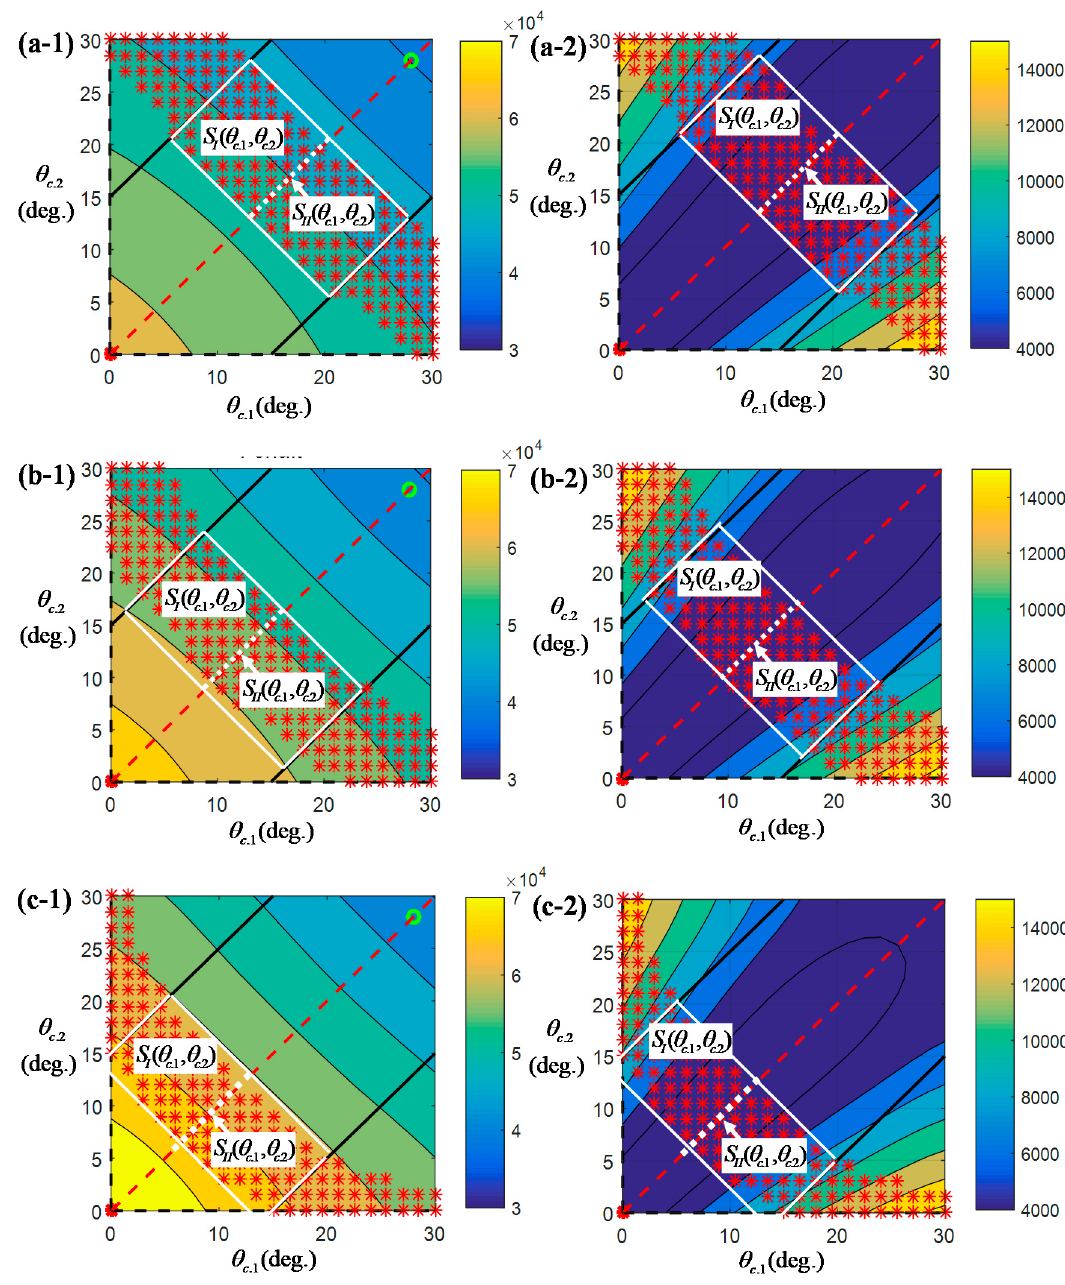
Figure 9. Average steady-state radial and axial forces, F ave . radial ( θ c .1 , θ c .2 ) and F ave . axial ( θ c .1 , θ c .2 ) , on bearing with various wind speeds (( a-1 ) and ( a-2 ) for V m = 10 m / sec, ( b-1 ) and ( b-2 ) for V m = 12 m / sec, ( c-1 ) and ( c-2 ) for V m = 14 m / sec